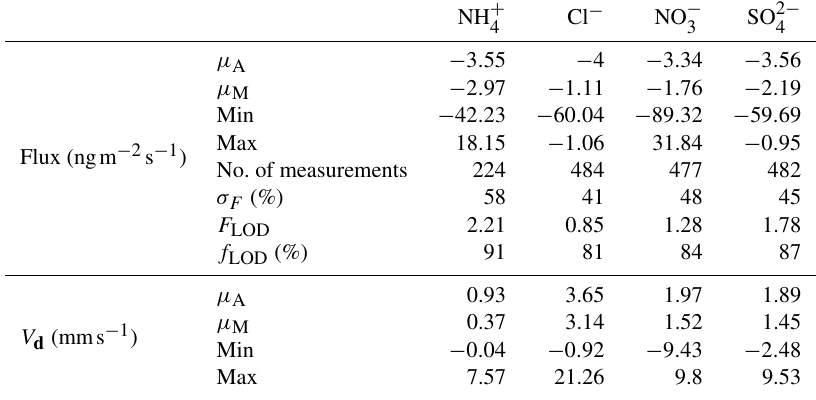
Table 3. Mean ( µ A ), median ( µ M ), minimum and maximum values for flux and deposition velocity ( V d ) for water-soluble aerosols measured during the Easter Bush campaign. Also shown are the median relative standard error ( σ F ), the flux limit of detection ( F LOD ) evaluated for typical conditions (median u ∗ and median concentration) and the fraction of the hourly flux value that exceeds the flux detection limit evaluated for that hour ( f LOD